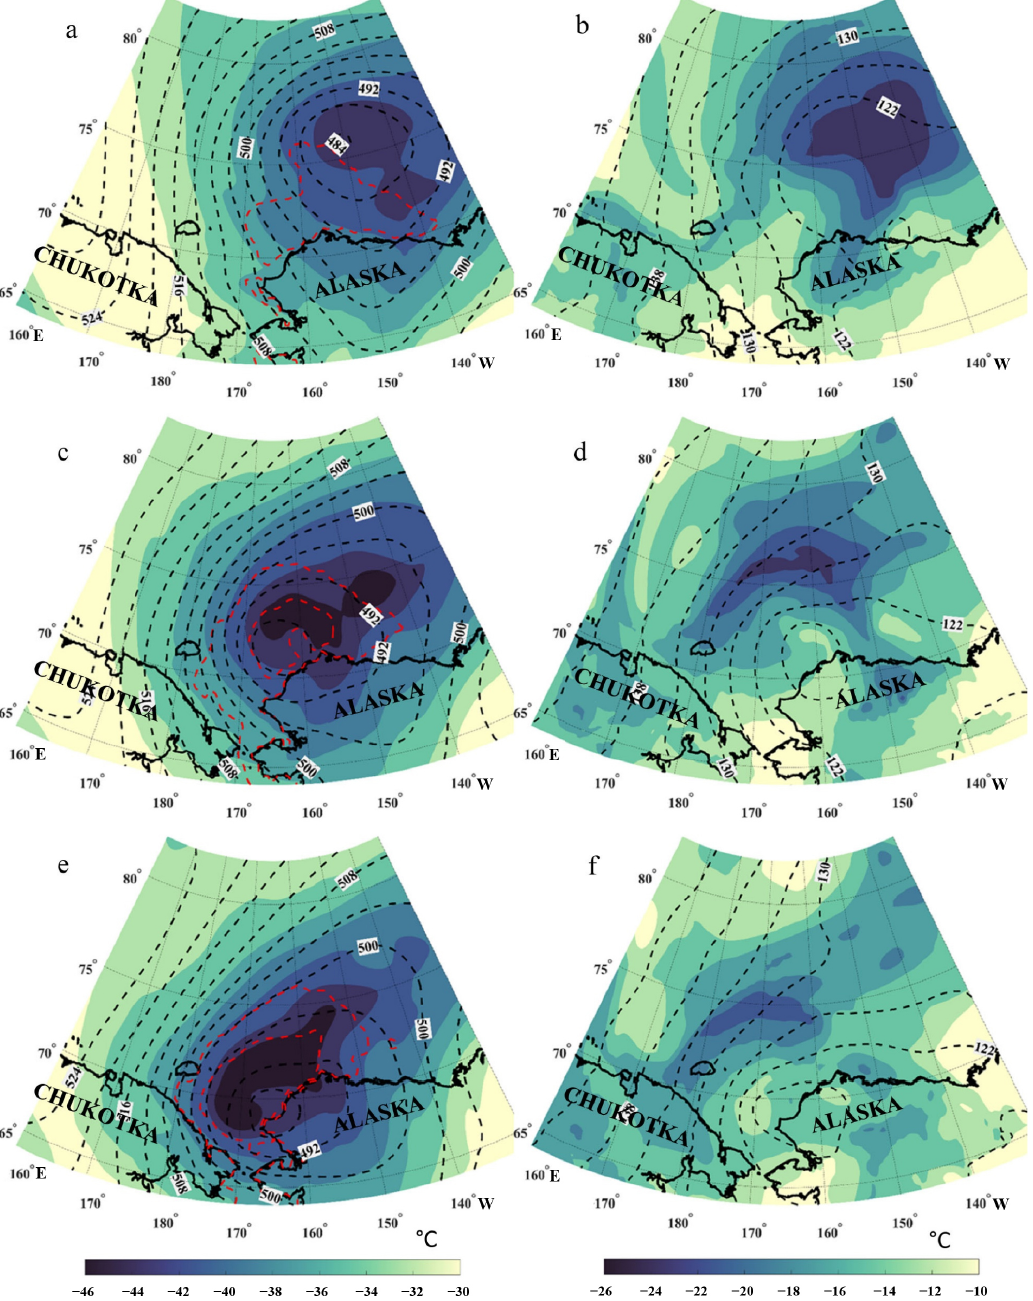
Figure 3. The geopotential heights (dm; black dotted lines) and air temperature ( ◦ C, shading) from the ERA5 reanalysis for 500 hPa (left column) and 850 hPa (right column) at 23:00 UTC, 18 October ( a , b ), 14:00 UTC ( c , d ) and 23:00 UTC ( e , f ) of 19 October 2017. Red dotted lines outline areas with a difference of 40 ◦ K and 45 ◦ K between the SST and air temperature at the 500 hPa